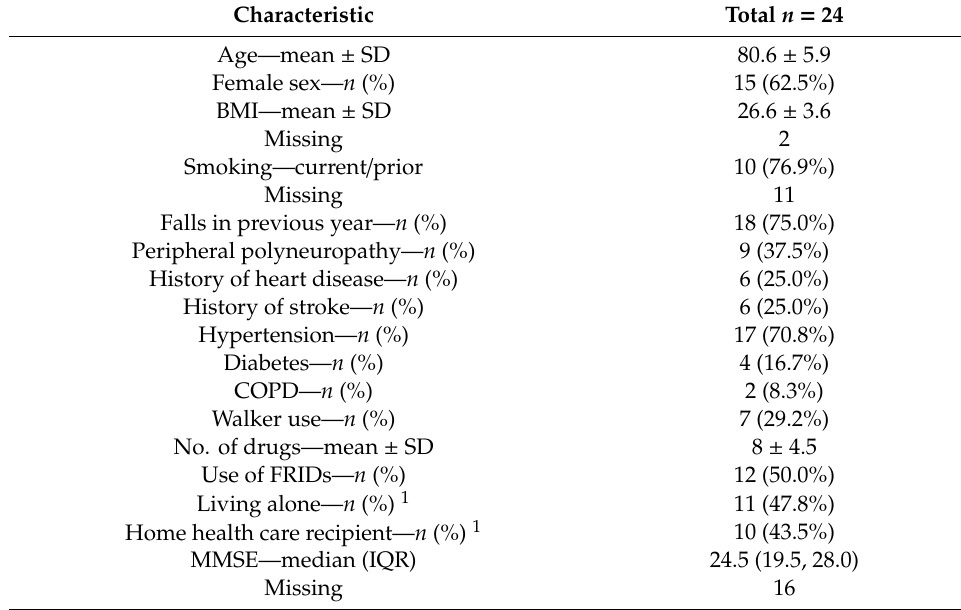
Table 1. Characteristics of included